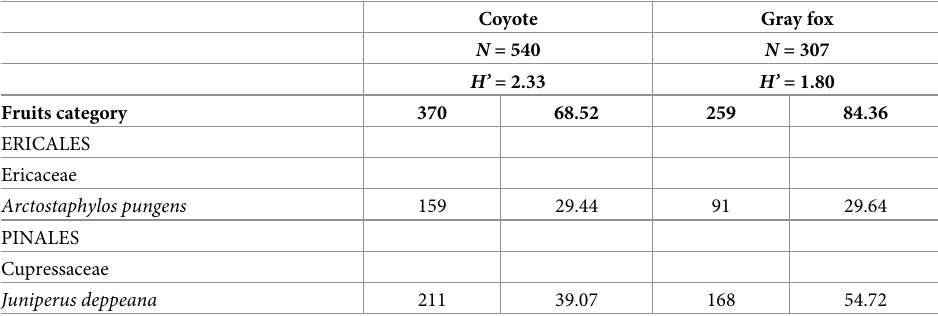
PLOS ONE | https://doi.org/10.1371/journal.pone.0260325 December1,